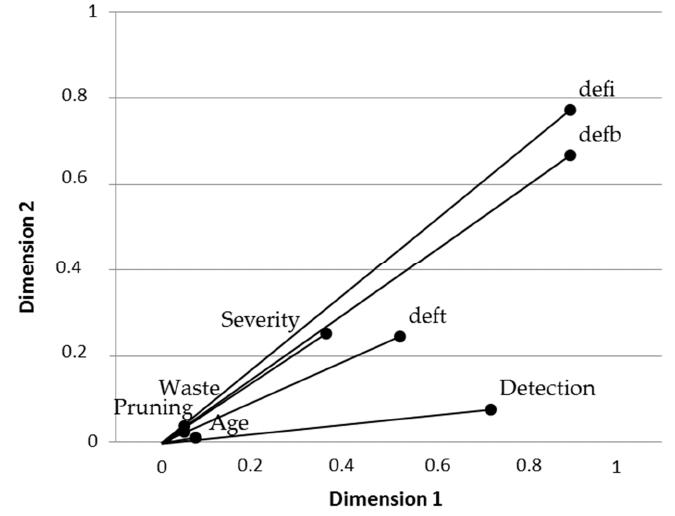
Figure 4. Multiple correspondence analysis (MCA) dimensions contain variances, indicating which Figure 3. Relationship among fungal infection severity, symptoms, and tree characteristics in the variables are related along which surveyed plantations. Variety and dimensions of dichotomized presence absence of needle pathogenic species, healthy vs. unhealthy, visualized with multiple correspondence analysis and the